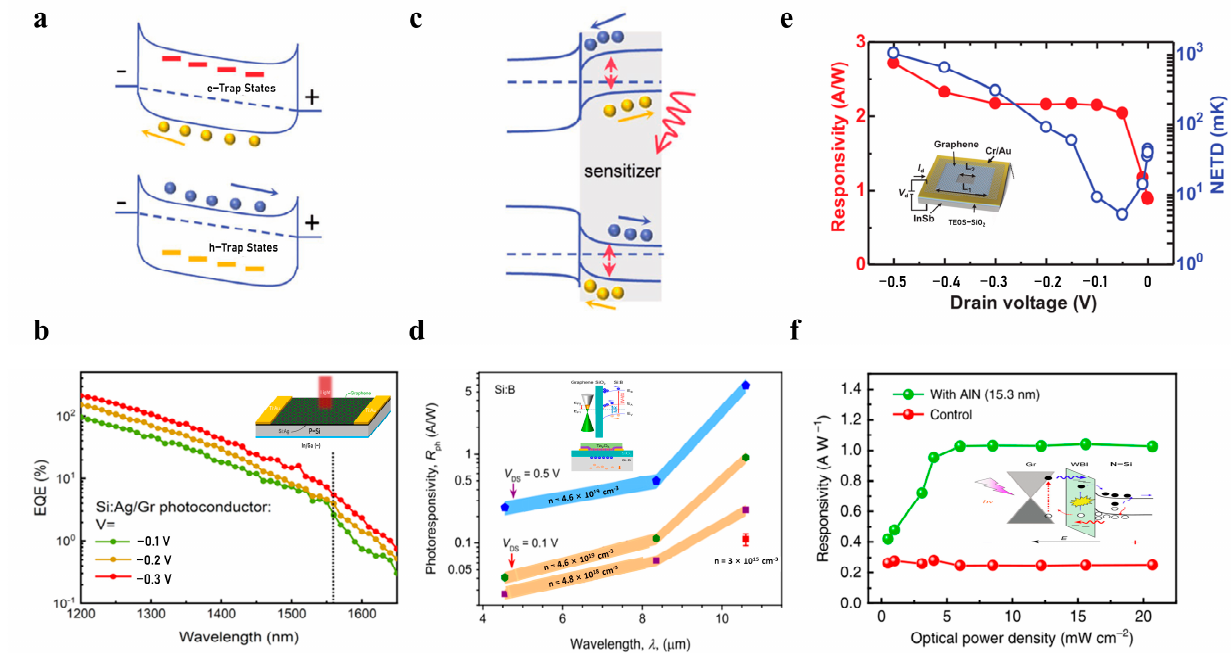
Figure 5. High-responsivity infrared photodetection. ( a , c ) Schematic diagrams of photogating effect [90] (copyright 2017, John Wiley and Sons). ( b ) Schematic diagram of graphene/Si:Ag heterostructure infrared detector and its EQE [92] (copyright 2022, Elsevier). ( d ) Schematic diagram of energy band structure and responsivity of graphene/Si:B detector [93] (copyright 2022, American Chemical Society). ( e ) Schematic diagram of graphene/undoped InSb heterostructure infrared detector and its responsivity [94] (copyright 2022, AIP Publishing). ( f ) Schematic diagram of graphene/insulation/silicon detector and its optical power-dependent responsivity [99] (copyright 2021, Springer Nature).